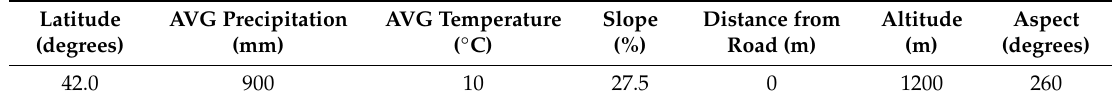
Table 4. Initial plot conditions.